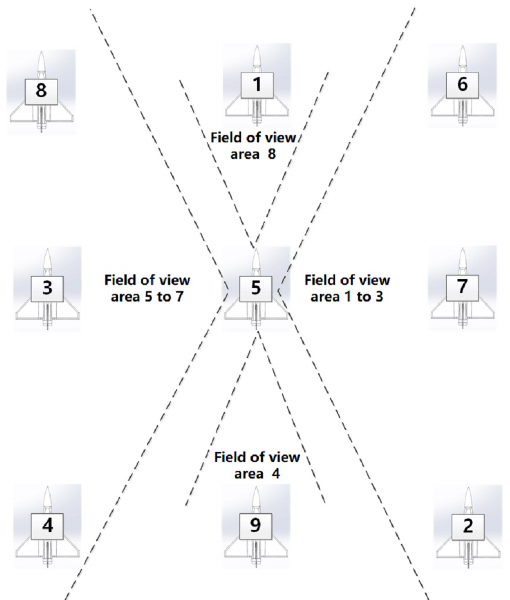
Figure 5. Corresponding directions diagram for the visual range of a single UAV in a 3 × 3 magic